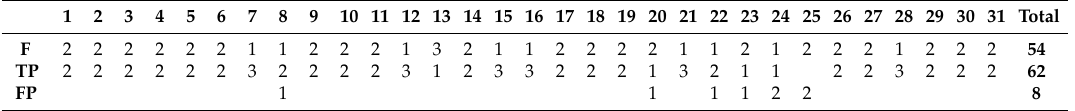
Table 2. The number of false positives (FP), true positives (TP), and fails (F) per queried